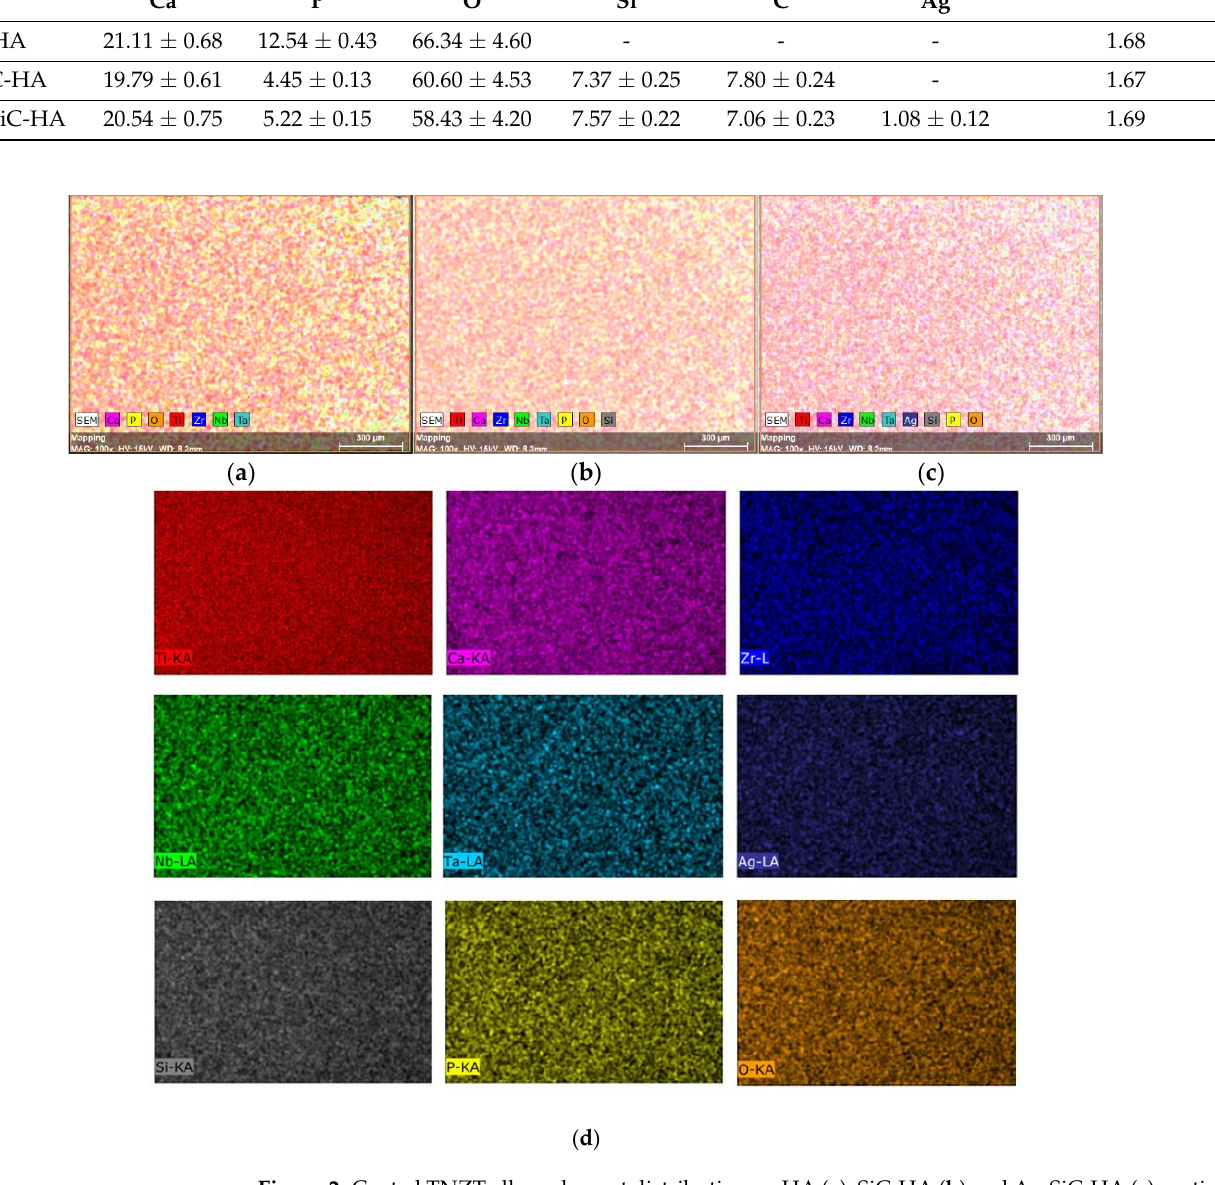
Figure 2. Coated TNZT alloy: element distribution on HA ( a ), SiC-HA ( b ) and Ag-SiC-HA ( c ) coatings (magnification 100×); ( d ) distribution of each individual element in Ag-SiC-HA coating. The crystallographic structure of all the deposited coatings was determined on one replicate of each type of coating deposited on TNZT alloy and Si. The X-ray diffraction patterns of the coatings deposited on the TNZT alloy are presented in Figure 3, along with the XRD pattern of the bare alloy. TNZT alloy presents the hexagonal α (cid:48) martensite structure (cell parameters: a = 0.2993 nm, c = 0.4642 nm), and the β bcc phase (a small peak partially overlapped on α (cid:48) maximum). A grain size value of 20.9 ± 0.3 nm was obtained for α (cid:48) phase, derived from the (101) maximum peak using the Scherrer formula [50]. The TNZT structure is similar to the ones reported for other TiNbZrTa alloys, with different elements concentrations